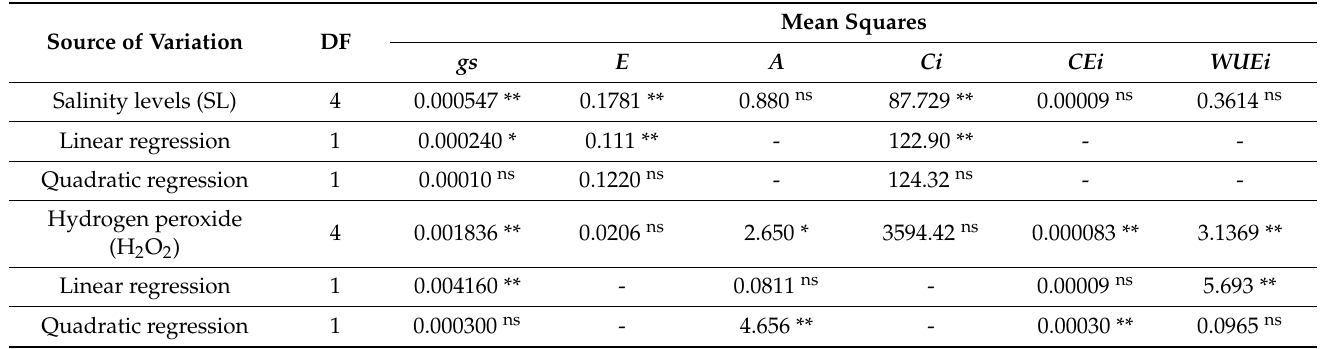
Table 1. Analysis of variance (F-test) summary of stomatal conductance ( gs ), transpirati € ( E ), CO